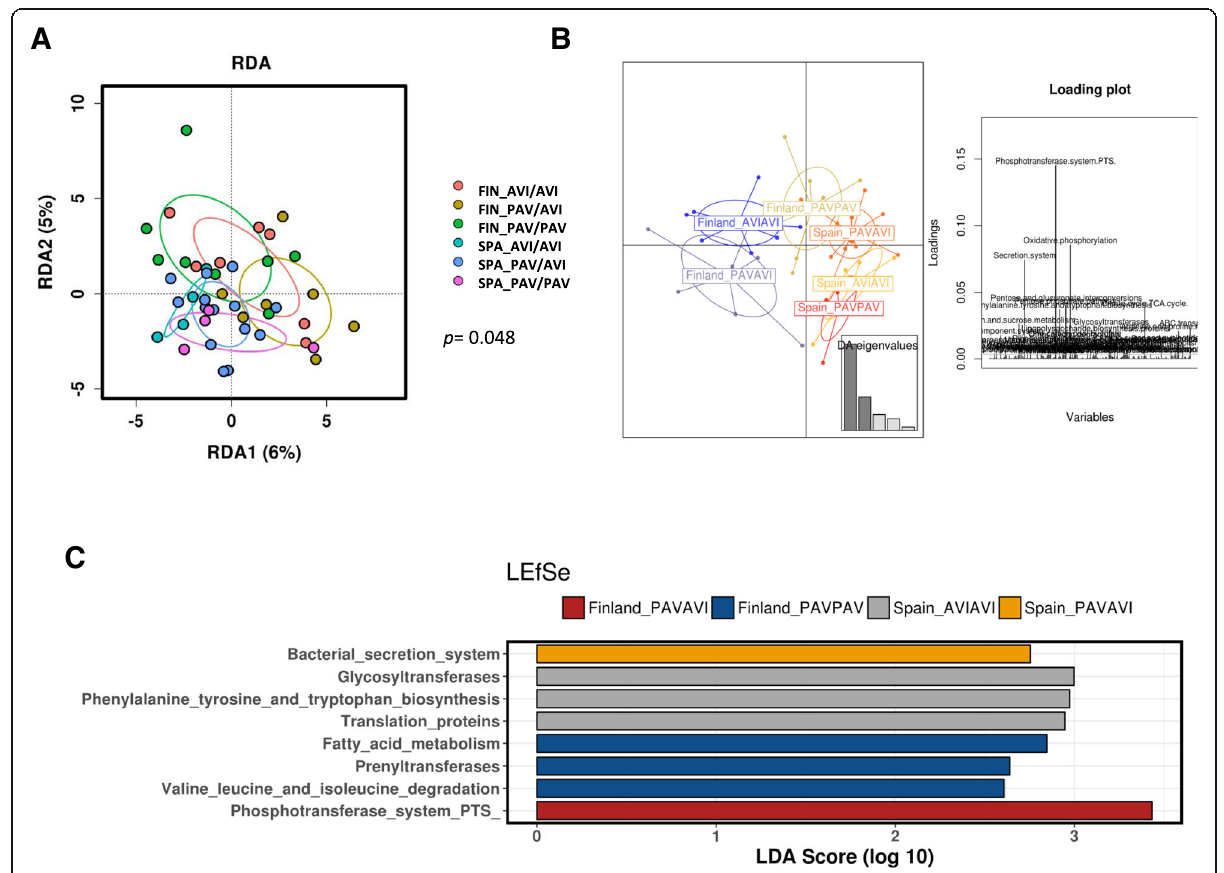
Fig. 3 Abundant pathways in the oral microbiome according to taste genotype and country. a RDA plots based on KEGG pathways (level 2), ellipses represent 95% confidence intervals from centroids of the interaction between pathways. b Discriminant analysis of principal components (DAPC) plot at KEGG pathways (level 2). The individual peaks in the loading plot show the variable influence on the cluster separation (0.05 threshold level). c LEfSE test revealed distinct KEGG pathways in taste and country